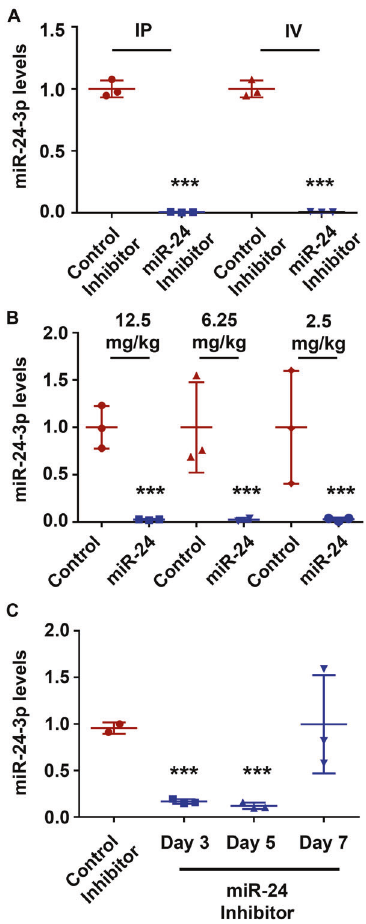
Fig. 2 A cell-permeable miR-24-3p inhibitor is effective in the colon 5 days after one dose. A Mice received an intraperitoneal (IP) or intravenous (IV) injection of 12.5 mg/kg control inhibitor or miR- 24-3p (miR-24) inhibitor and colonic RNA was extracted 4 days later. n = 3 mice per group, for IP/IV representative of two independent experiments. Mean ± SD. B IP injections of 12.5, 6.25, and 2.5 mg/kg of a miR-24-3p inhibitor (miR-24) were tested for their ef fi cacy at 4 days post injection. n = 3 mice per group, representative of two independent experiments. Mean ± SD. C Mice were IP injected with 2.5 mg/kg of a miR-24-3p inhibitor and were sacri fi ced 3, 5, or 7 days later. n = 3 mice per group. Mean ± SD. *** p <